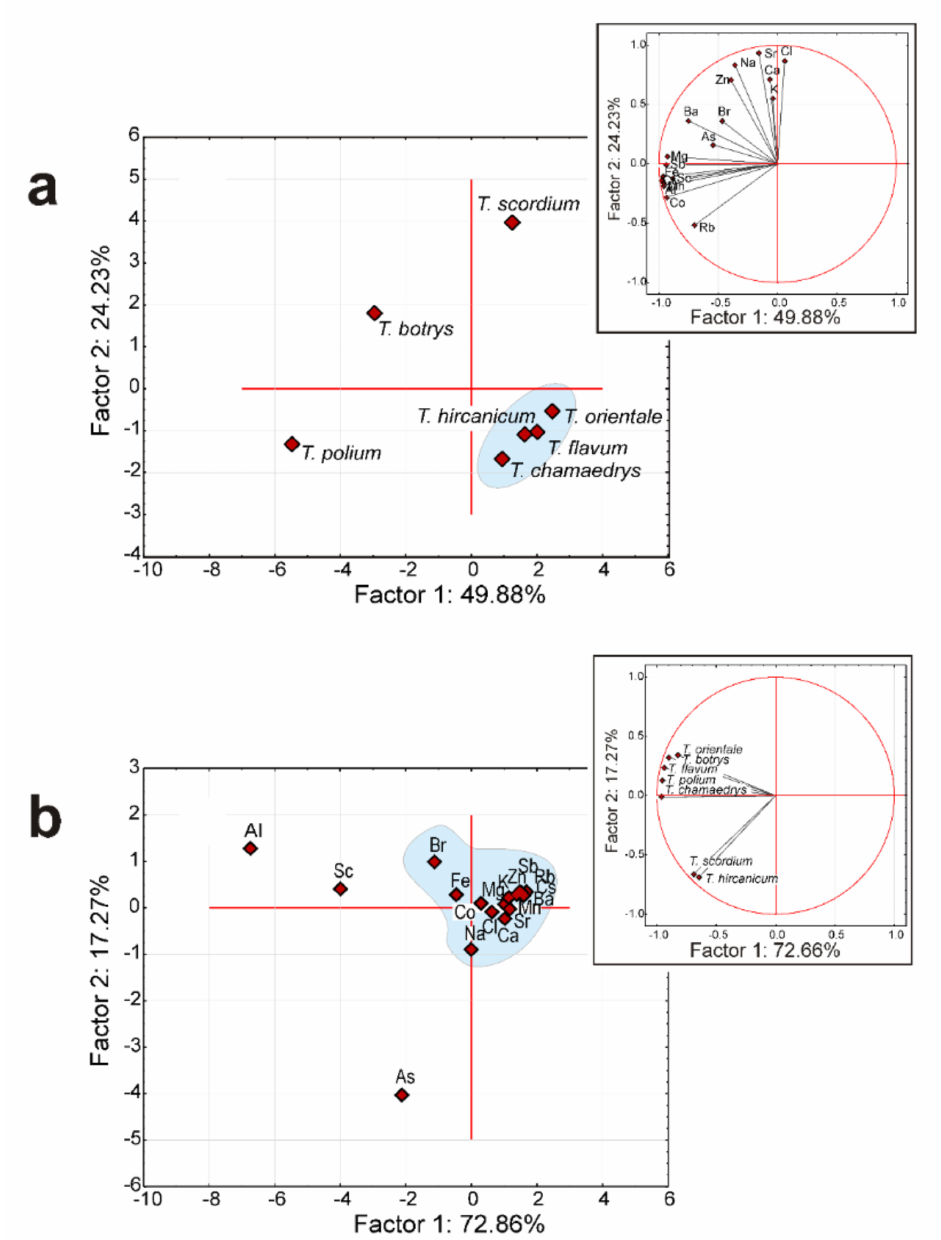
Figure 2. Biplots illustrating the results of Q ( a )- and R ( b )-mode PCA. The distribution of the first and second factor loadings is reproduced in the corresponding